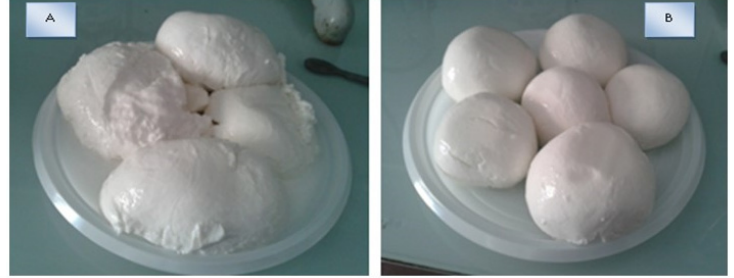
Figure 2. Goat mozzarella obtained with protocol ( A , B ) after 7 days refrigerated storage.